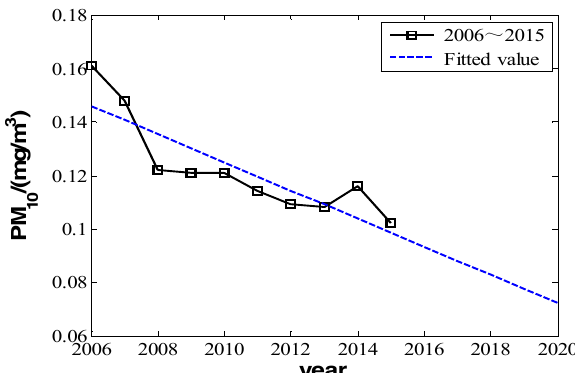
Figure 6. The actual value and predicted value of inhalable particulate matters’ annual daily mean in 2006 to 2020.